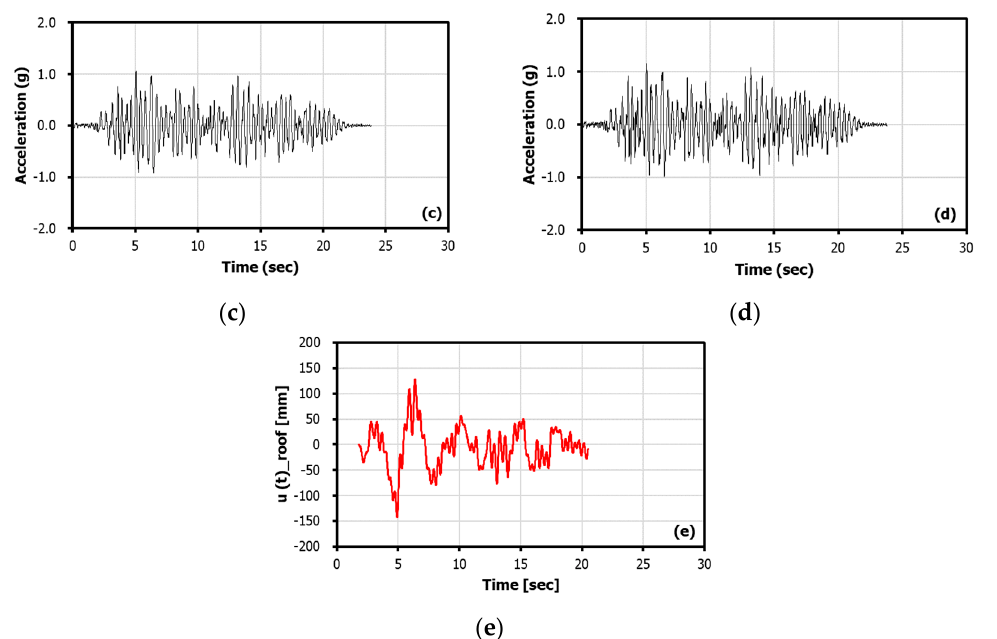
Figure 10. Dynamic response and roof displacement of the model for the Superstition Hills earthquake; ( a ) base acceleration, ( b ) 4th floor acceleration, ( c ) 7th floor acceleration, ( d ) roof acceleration, and ( e ) roof displacement.